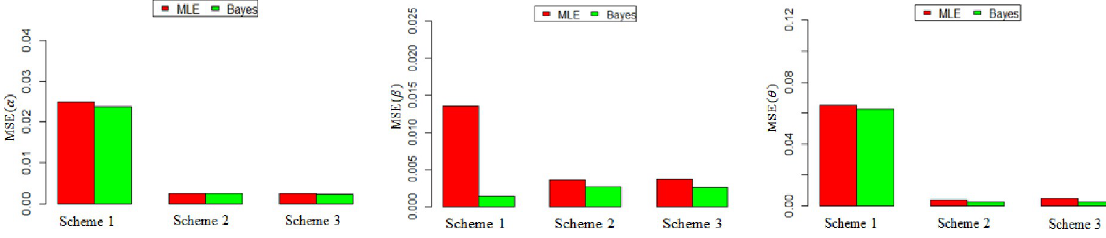
Fig 2. MSE of MOP parameters with various schemes with n = 50 and α = 2.5, θ = 1.5, β = 0.5. https://doi.org/10.1371/journal.pone.0270750.g002 In Tables 4 and 5, we present the MLE for α , β , and θ as well as the Bayes estimates of α , β , and θ , under the loss functions. Numerical results of Bayes estimate for α , β , and θ , and their corresponding Bias and MSE values are computed in case 1,2 respectively, for different sample size ( n ) under different schemes. We observe that the Bayes estimates perform better than MLE in terms of Bias and MSE values. For fixed n , when the number of failures increase the Bias MSE decrease in all cases and for different estimators. Comparing the three censoring schemes, it is observed that in most of the case 1and 2, Scheme 3 perform better than schemes 1 and 2 in terms of Bias and MSE values.